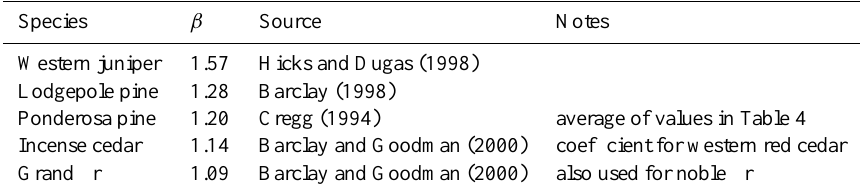
Table 1. Species conversion coefficients ( β ) relating leaf projected surface area to one half of total surface area. Species β Source Notes Western juniper 1.57 Hicks and Dugas (1998) Lodgepole pine 1.28 Barclay (1998) Ponderosa pine 1.20 Cregg (1994) average of values in Table 4 Incense cedar 1.14 Barclay and Goodman (2000) coefficient for western red cedar Grand fir 1.09 Barclay and Goodman (2000) also used for noble